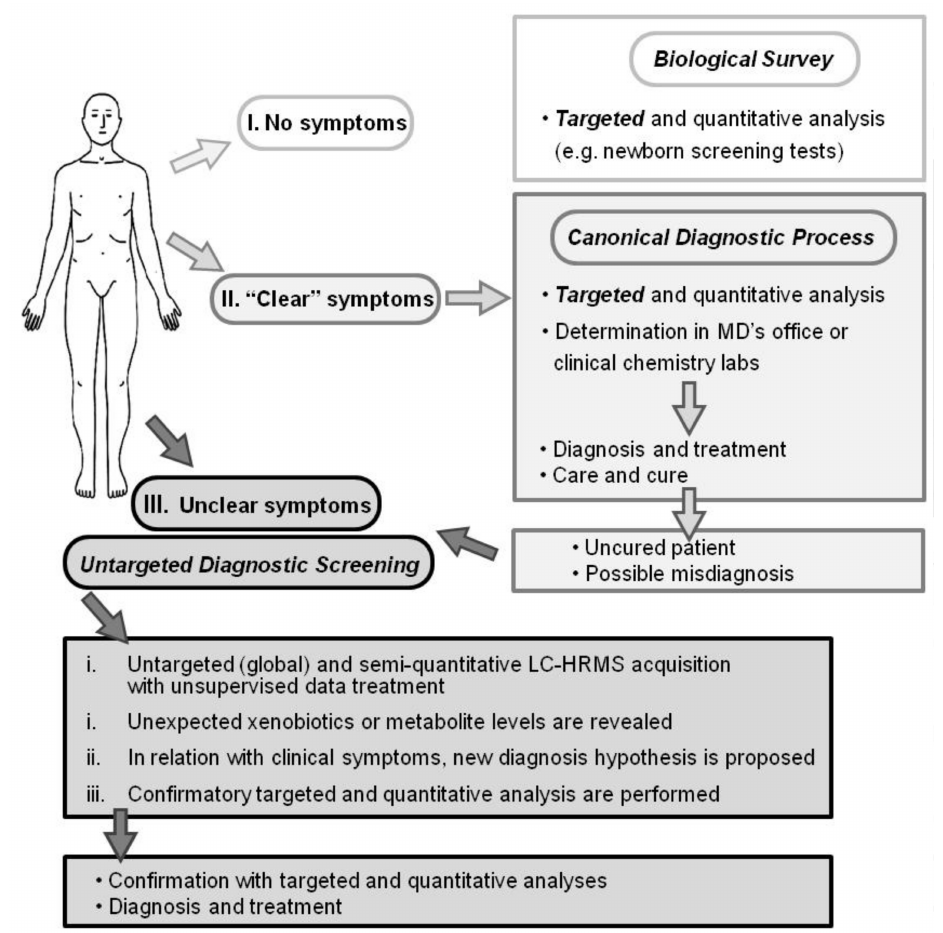
Figure 1. Diagnostic processes depicted as I. a biological survey (e.g., inborn error screening tests), II. Canonical practice (usual symptoms and diseases), and III. Untargeted diagnostic screening